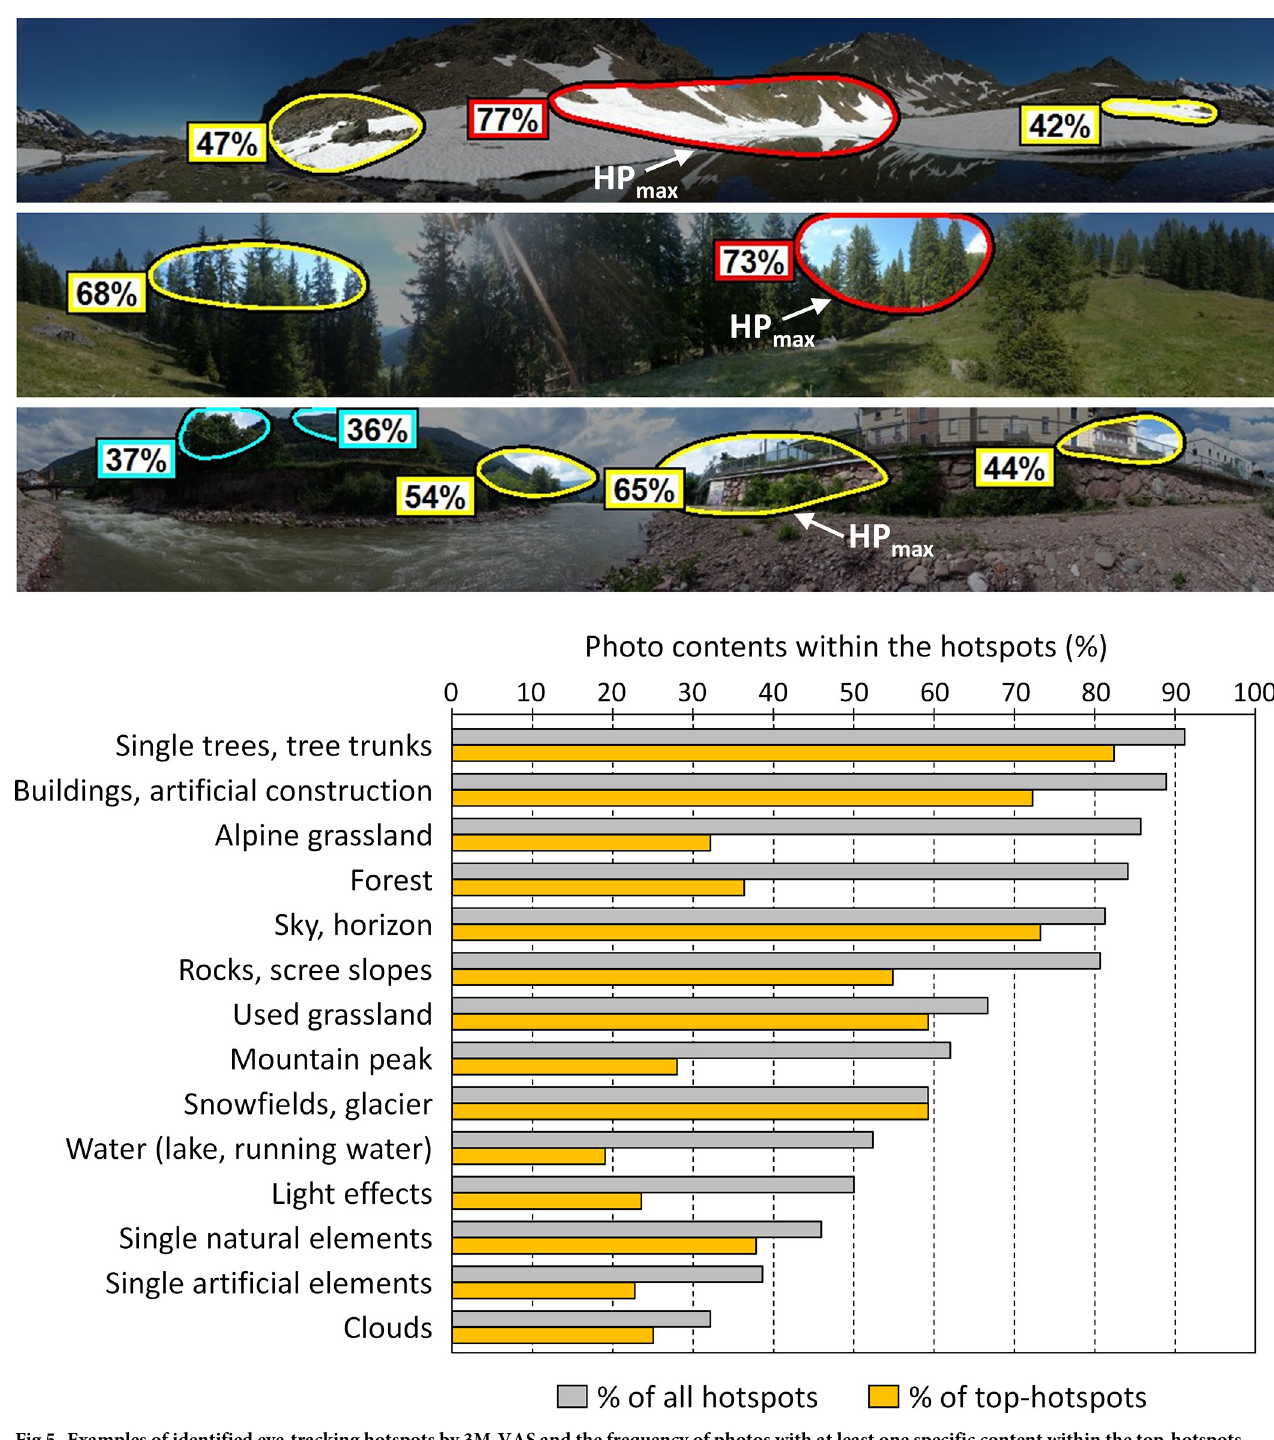
Fig 5. Examples of identified eye-tracking hotspots by 3M-VAS and the frequency of photos with at least one specific content within the top-hotspots (HP max ) and all hotspots. Frequencies were calculated considering only those photos containing the specific contents, e.g., number of hotspots with water in relation to all photos including hotspots with water. Photographs from Schirpke et al. [11], published under the Creative Commons CC BY 4.0 license.